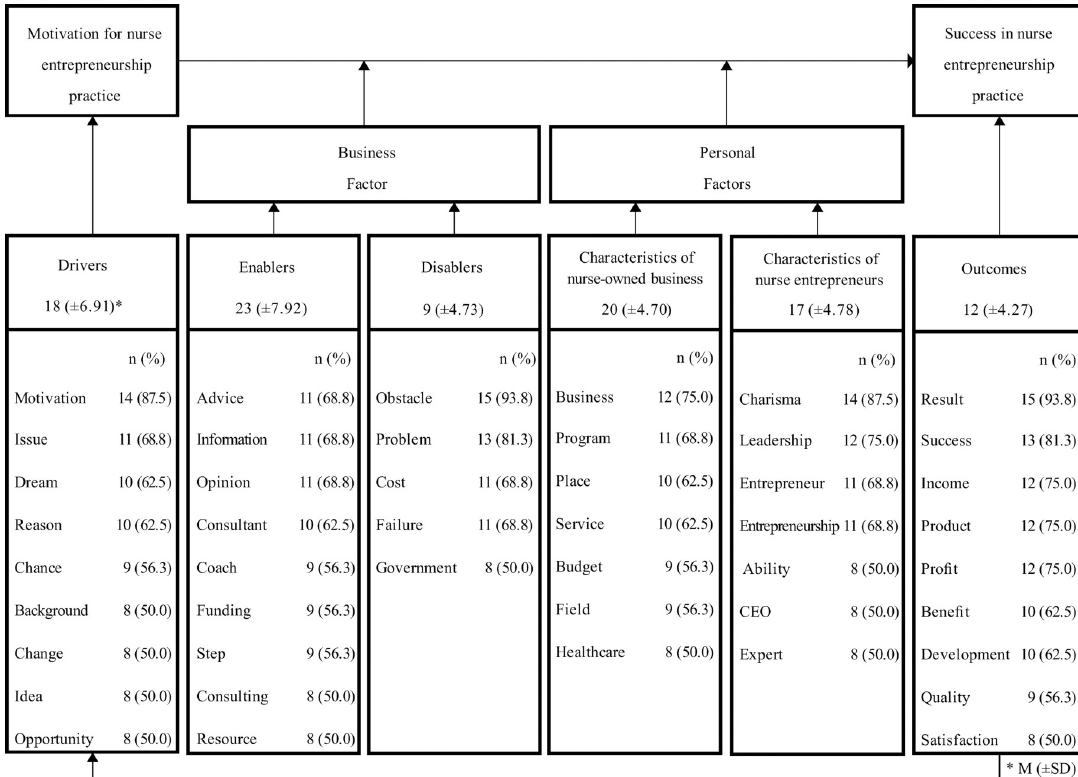
Fig 4. Classification of YouTube contents according to